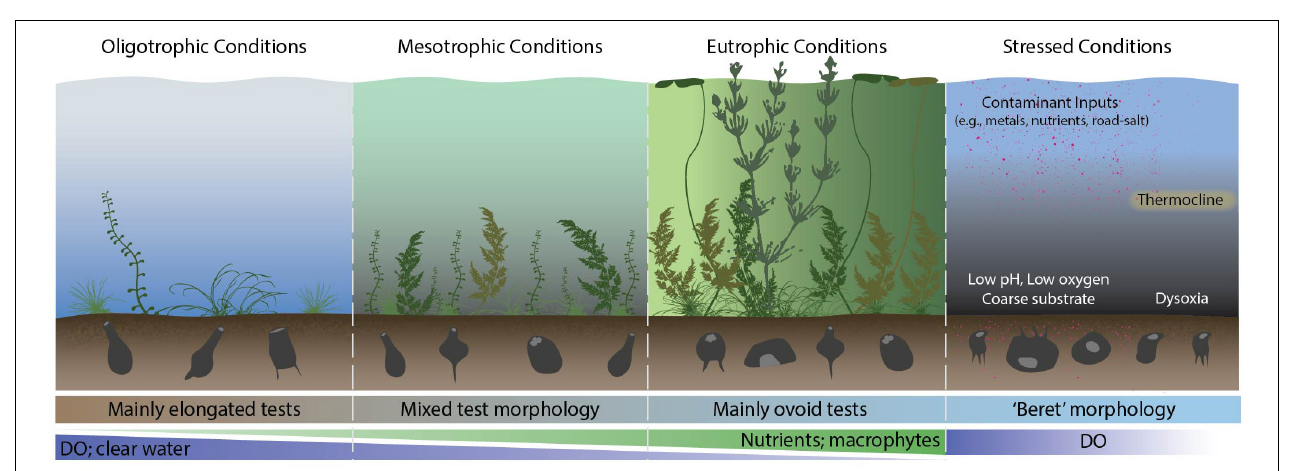
FIGURE 3 | An example of Arcellinida morphological variability in various types of lakes. DO, dissolved